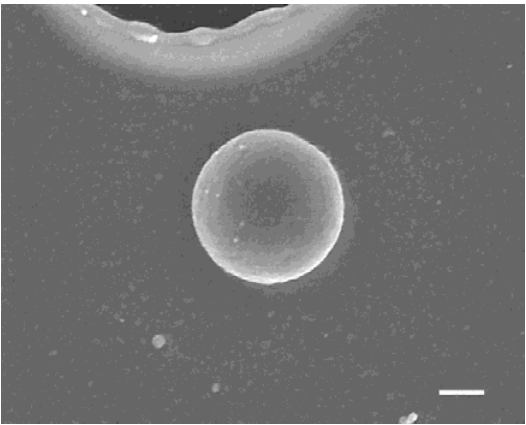
Figure 3. Observation with high-resolution scanning electron microscopy (HR-SEM) of a single nanoparticle shown in Figure 2a-1. The film thickness was 40 nm, and the fluence was 73.2 mJ/cm 2 . The radius was 175 nm. The white bar in the image represent 100 nm.